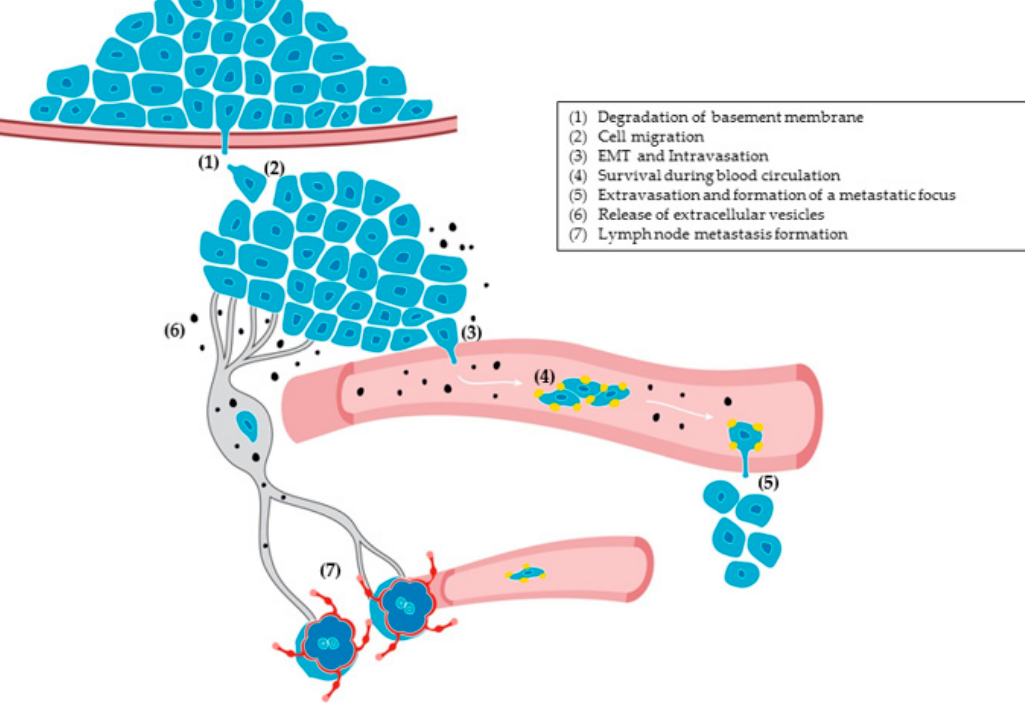
Figure 3. Simplified model showing the probable implication of podoplanin in different steps of the metastatic cascade. Cells from a premalignant tumor traverse the basement membrane using the proteolytic activity of invadopodia (1) and invade the connective issue (2) to form a malignant tumor. Tumor cells can undergo epithelial–mesenchymal transition (EMT) and enter into the blood stream by degrading the basement membrane of the blood vessel through invadopodia (3). Malignant cells resist against shear stress and inhibit immune cell assaults by activating and aggregating platelets (4). Platelet aggregation favours tumor-cell adhesion and emboli formation in the microvasculature; adhered tumor cells use invadopodia to extravasate from the blood vessel (5). Malignant cells secrete soluble factors and extracellular vesicles (6) that promote angiogenesis and lymphangiogenesis, and infiltrate pre-existing lymphatic vessels to reach the lymph nodes and form metastasis (7).